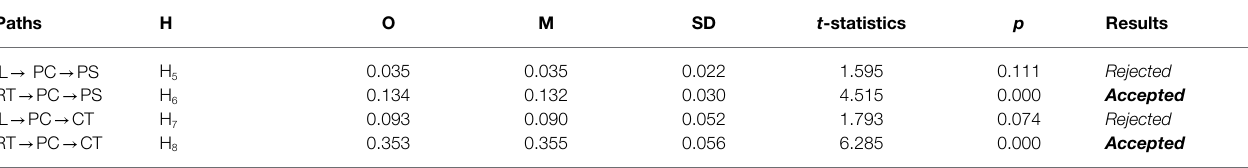
TABLE 7 | Indirect effects of the variable.